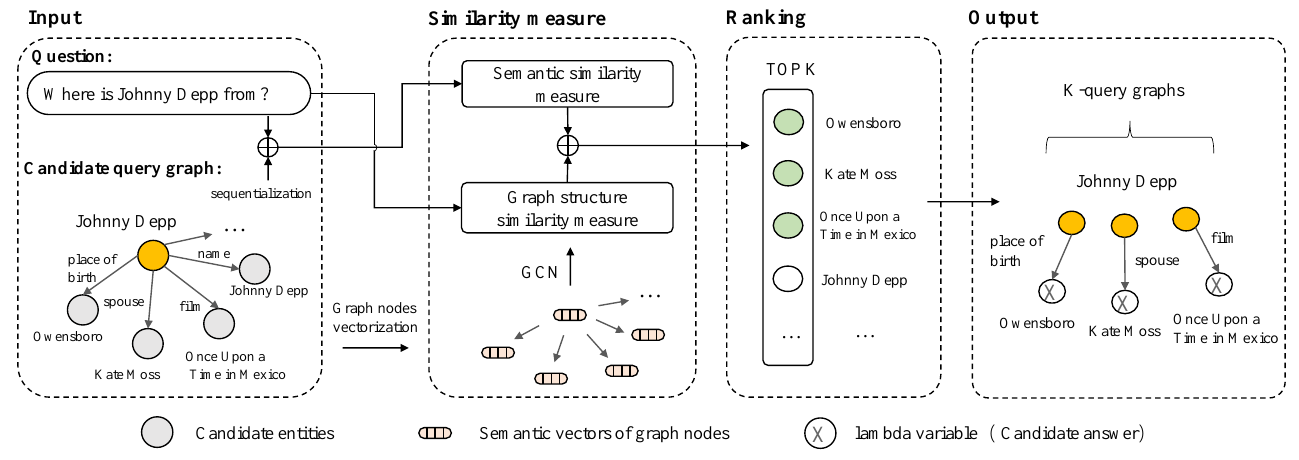
Figure 3. The structure of the query graph Ranker